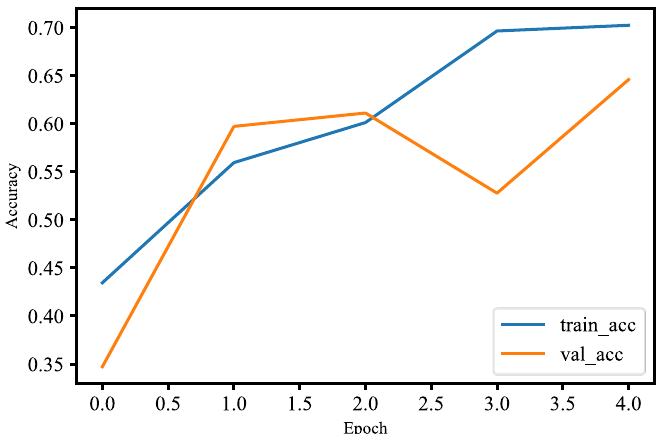
Figure 37. Loss of human face detection.